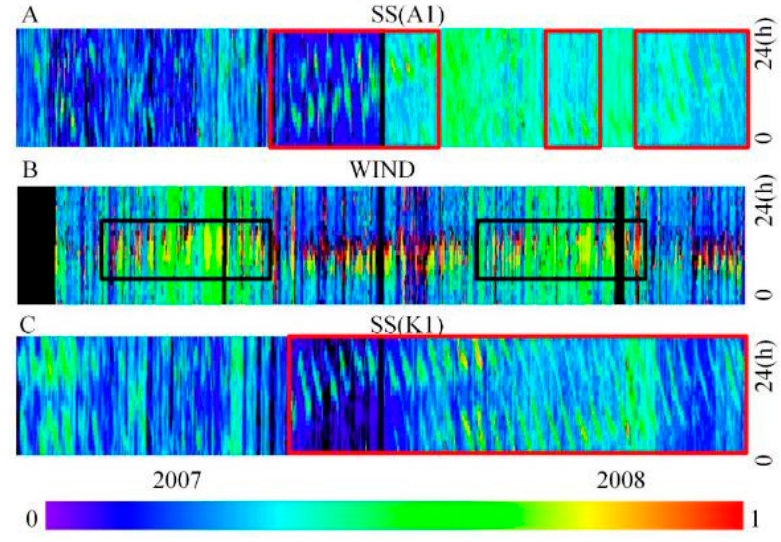
Figure 9. Raster image of suspended sediment (SS) at station A1 ( A ) and K1 ( C ) and wind speed ( B ) in 2007 and 2008. The color denotes the normalized values and black sections represent missing data. Red frames in the SS image indicate variations with regular patterns. Wind speed with black frames indicates high wind speed data, which corresponded to SS data with both a regular and irregular temporal pattern.